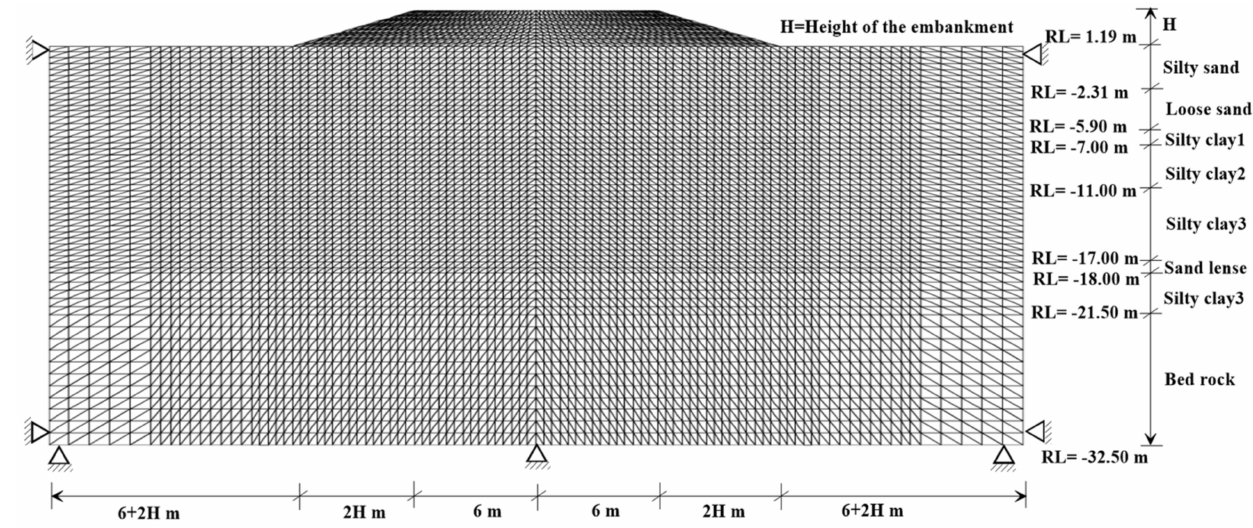
Figure 20. Finite element mesh used in the numerical solutions (Height, H = 3.0 m, 4.0 m) (see Islam and Gnanendran [8]).